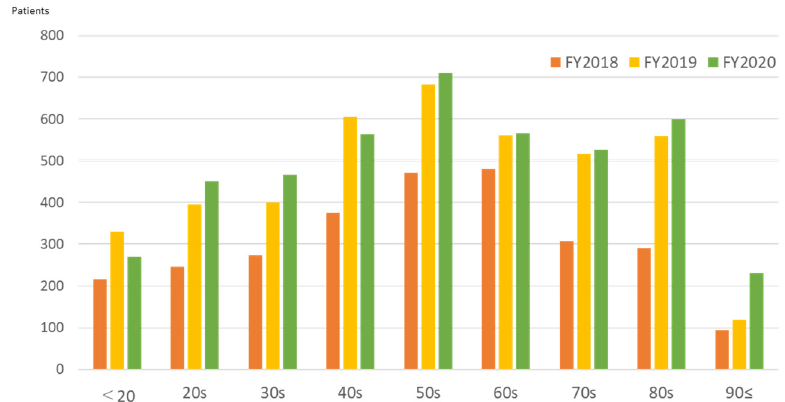
Figure 10. Annual number of outpatients treated at Futaba Medical Center by age cohort (years). Looking at the ICD of outpatients who were treated at FMC, more than 30% were